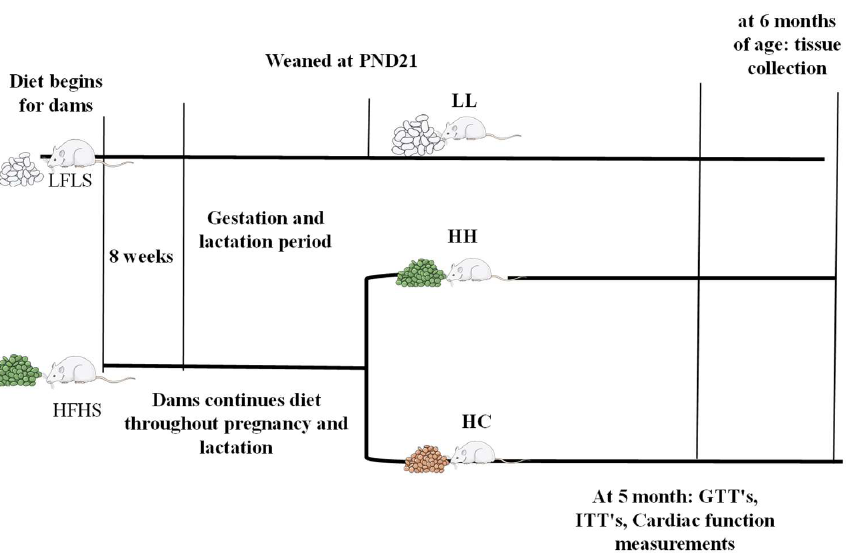
Figure 7. Experimental timeline. Mating was initiated after 8 weeks of diet intervention. LL, offspring born from maternal LFLS and postnatal LFLS; HH, maternal HFHS and postnatal HFHS; HC, maternal HFHS weaned onto a standard laboratory chow diet; PND, postnatal day.